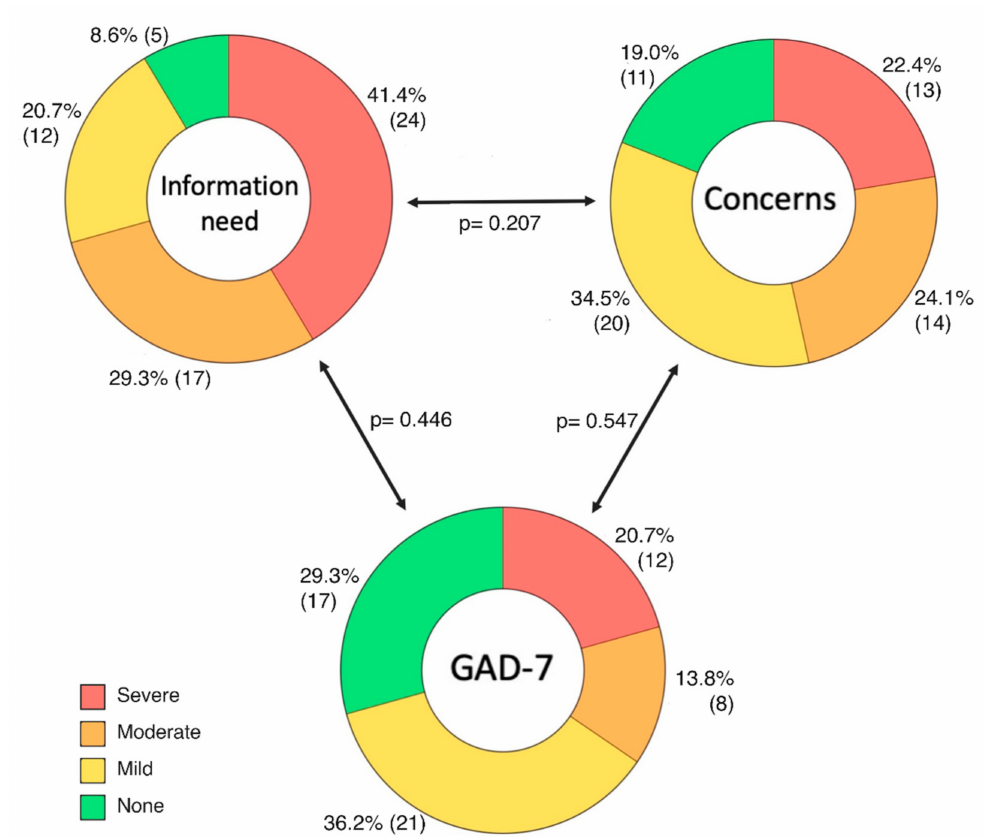
Figure 3. Psychological dimensions analyzed in families with PAH children during the COVID-19 pandemic: information need, concerns related to the pandemic and health, and anxiety as indicated by the GAD-7 questionnaire. Those three dimensions represent the summary of a group of questions and were categorized based on the thresholds specified in the Methods section. Percentages and numbers refer to the adjacent category; p -values refer to chi2 test result comparing two dimensions as indicated by